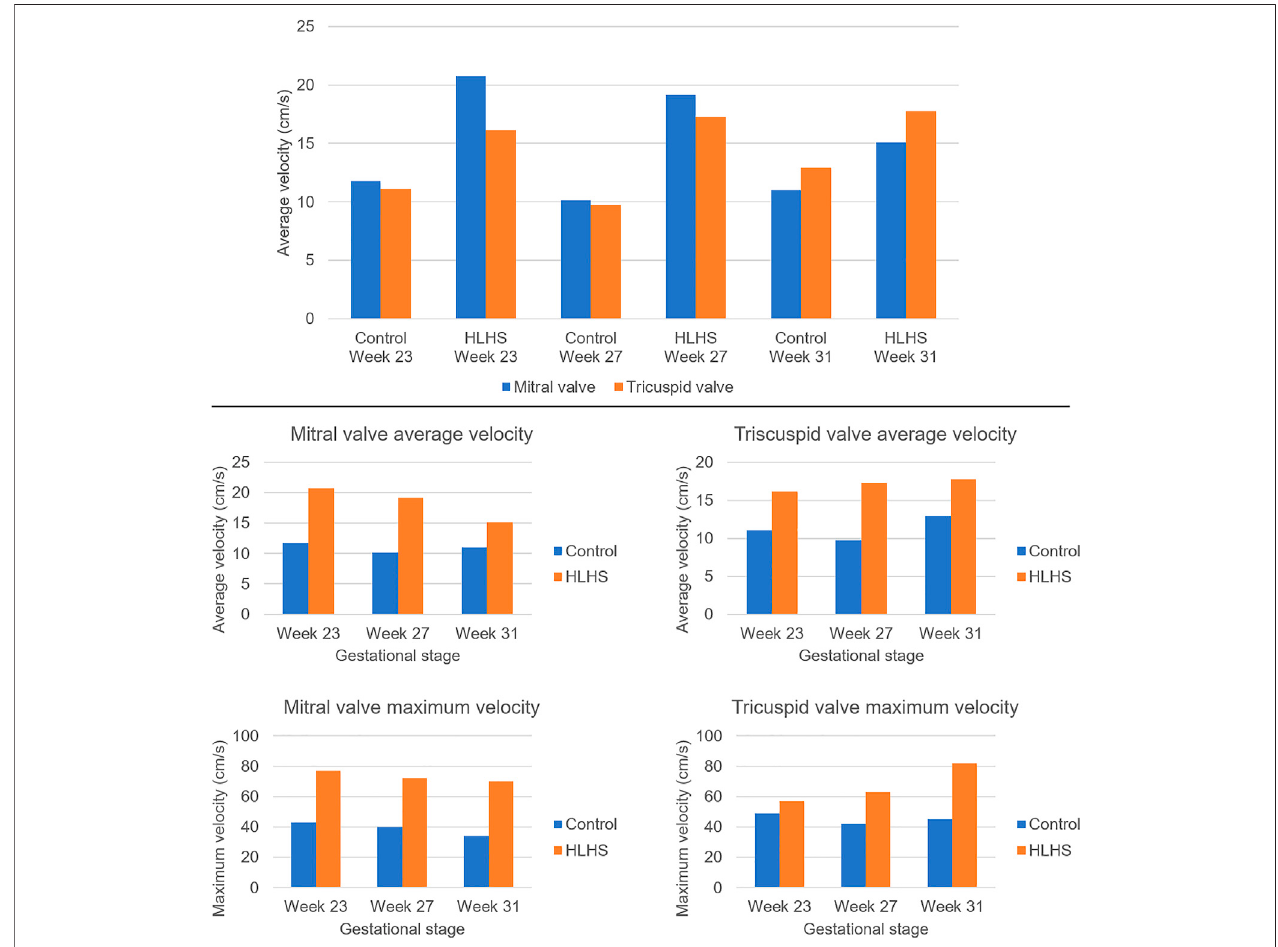
FIGURE 6 | Temporally averaged velocities in the mitral and tricuspid valves of the control and HLHS hearts at gestational stages of week 23, week 27, and week 31. The temporal averages are determined using the velocity levels within one full cardiac cycle.